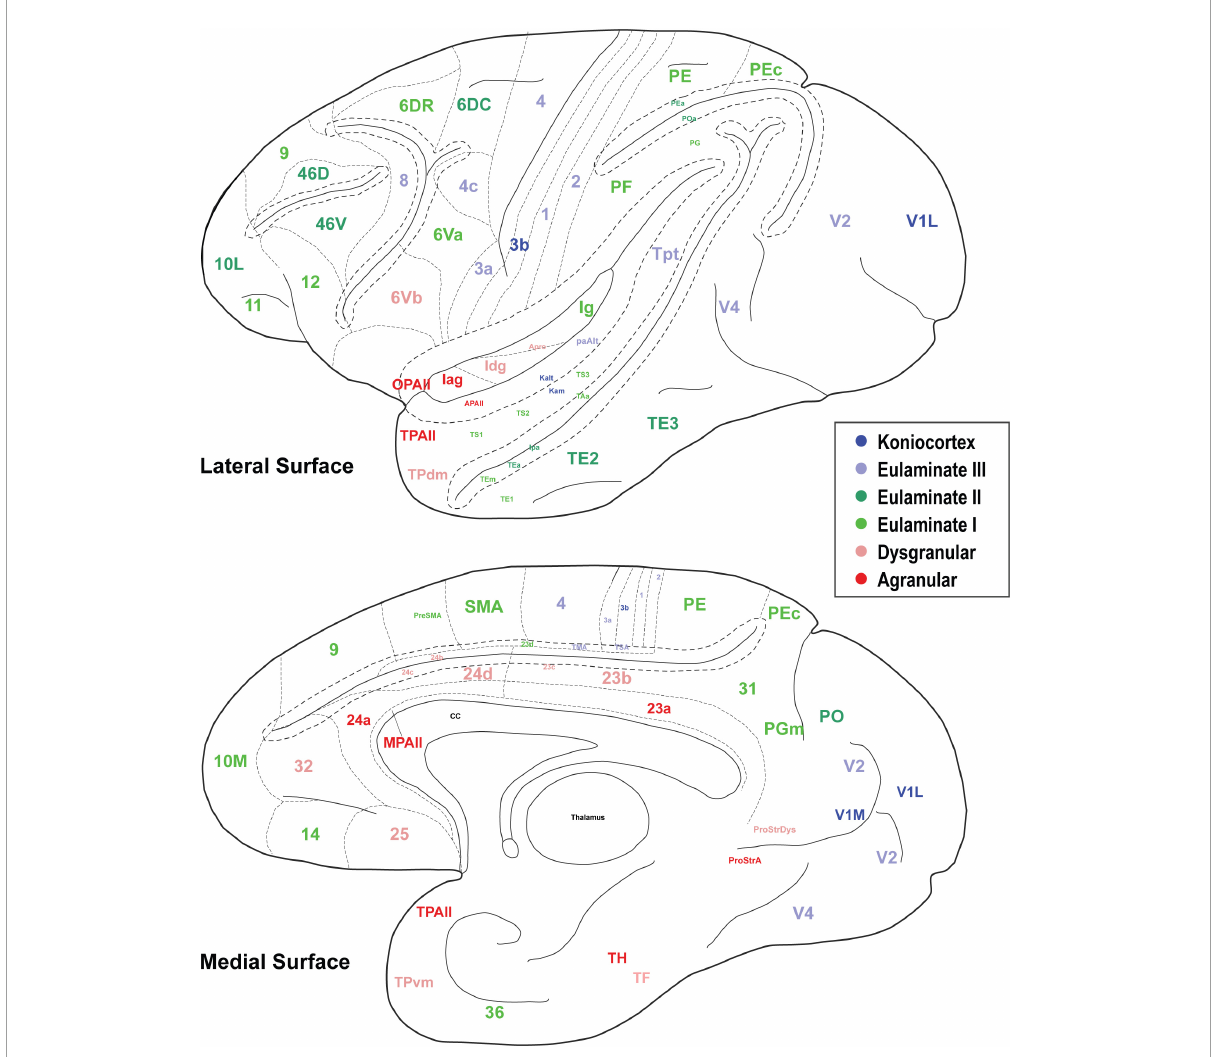
FIGURE5 The cortical spectrum. Seventy eight brain areas used in the analyses. Colors correspond to the subjective categorization performed by experts. Title location reflects approximate center of